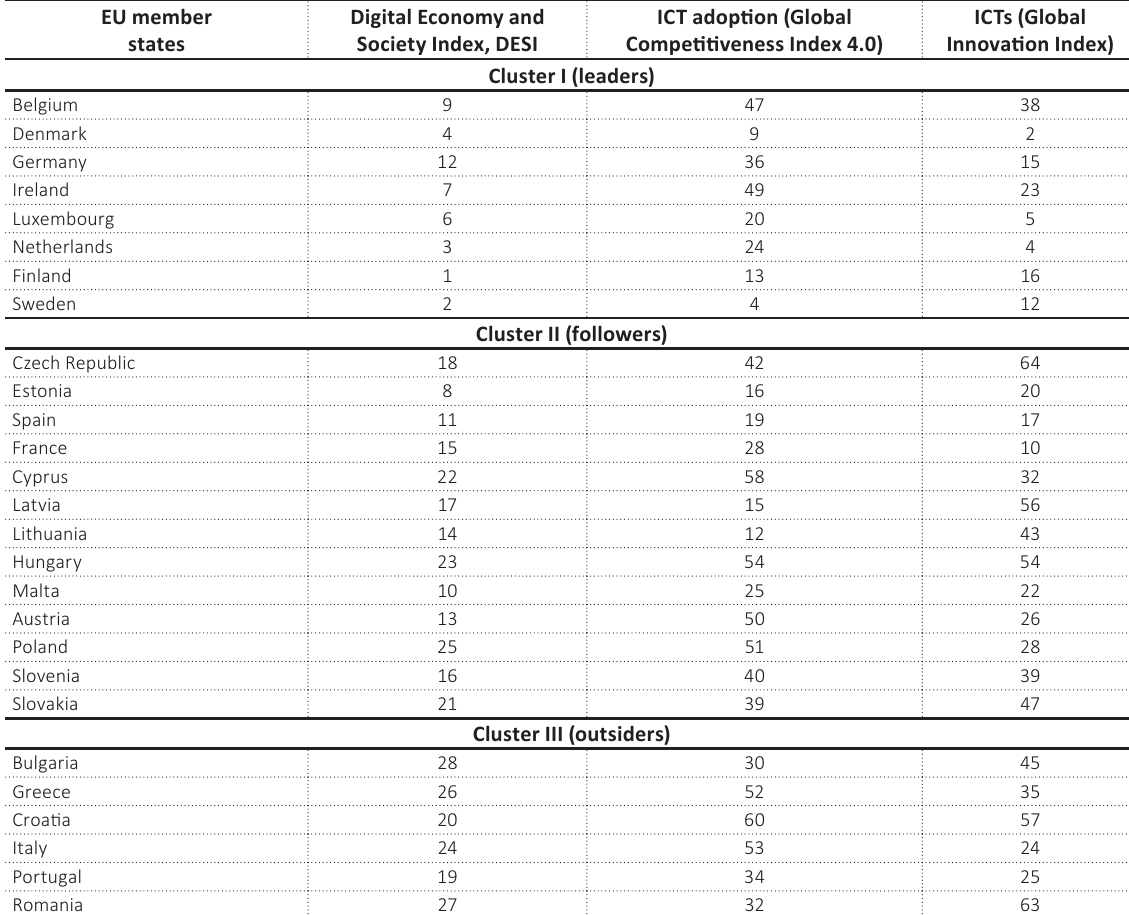
Table 3. Values of existing ratings, which reflect DE, for EU countries with the distribution by clusters